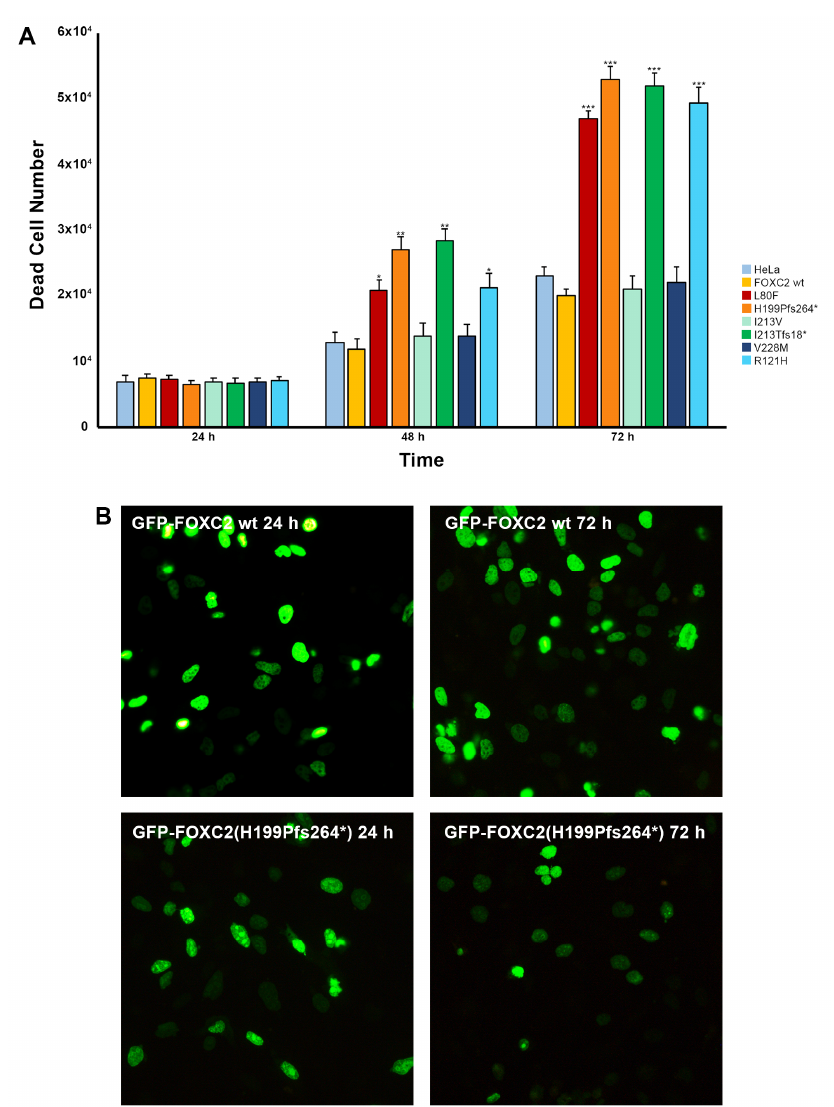
Figure 5. Viability analysis of HeLa cells transfected with native and mutant FOXC2-GFP constructs. ( A ) Statistical analysis of cell death in HeLa cells 24, 48 and 72 h after transient transfection with control and mutant FOXC2-GFP plasmids: average ± SD of at least three independent experiments. Statistical analysis was performed using the two-tailed Student’s t -test. * p < 0.05, ** p < 0.01, *** p = 0.000; ( B ) immunofluorescence analysis of pFOXC2-GFP and pFOXC 2 (H199Pfs*264)-GFP plasmids 24 and 72 h after transient transfection in HeLa cells. Nuclear localization of FOXC2 proteins was detected by direct immunofluorescence analysis of plasmids tagged with GFP (in green); 20 × magnification.